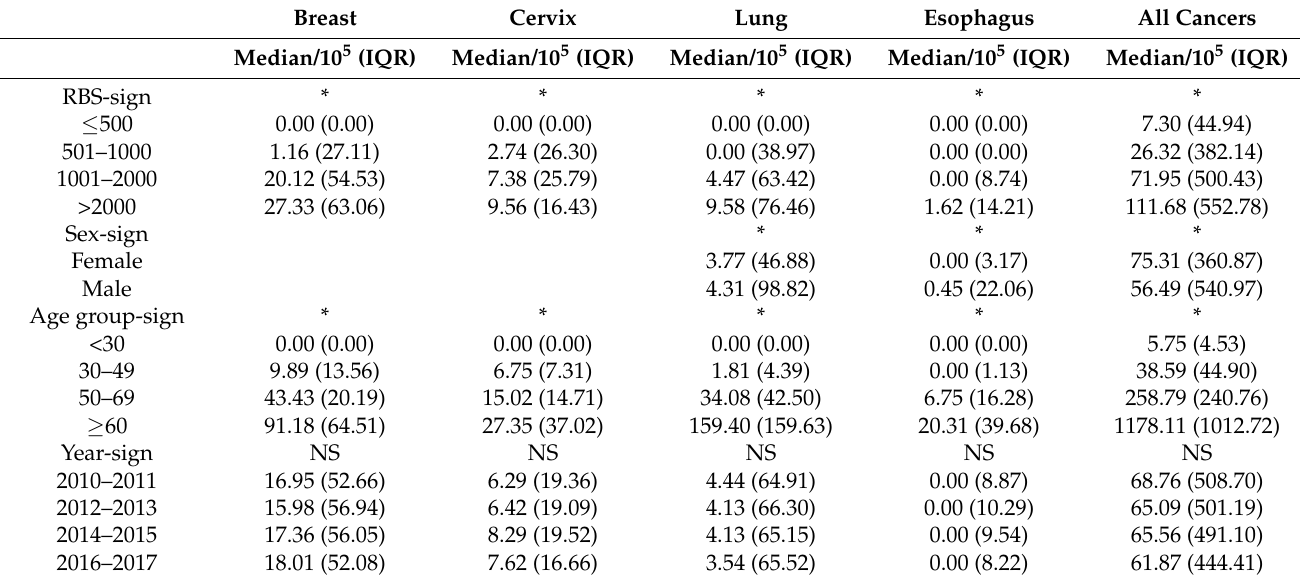
Table 1. Descriptive analysis of cancer mortality in Brazilian